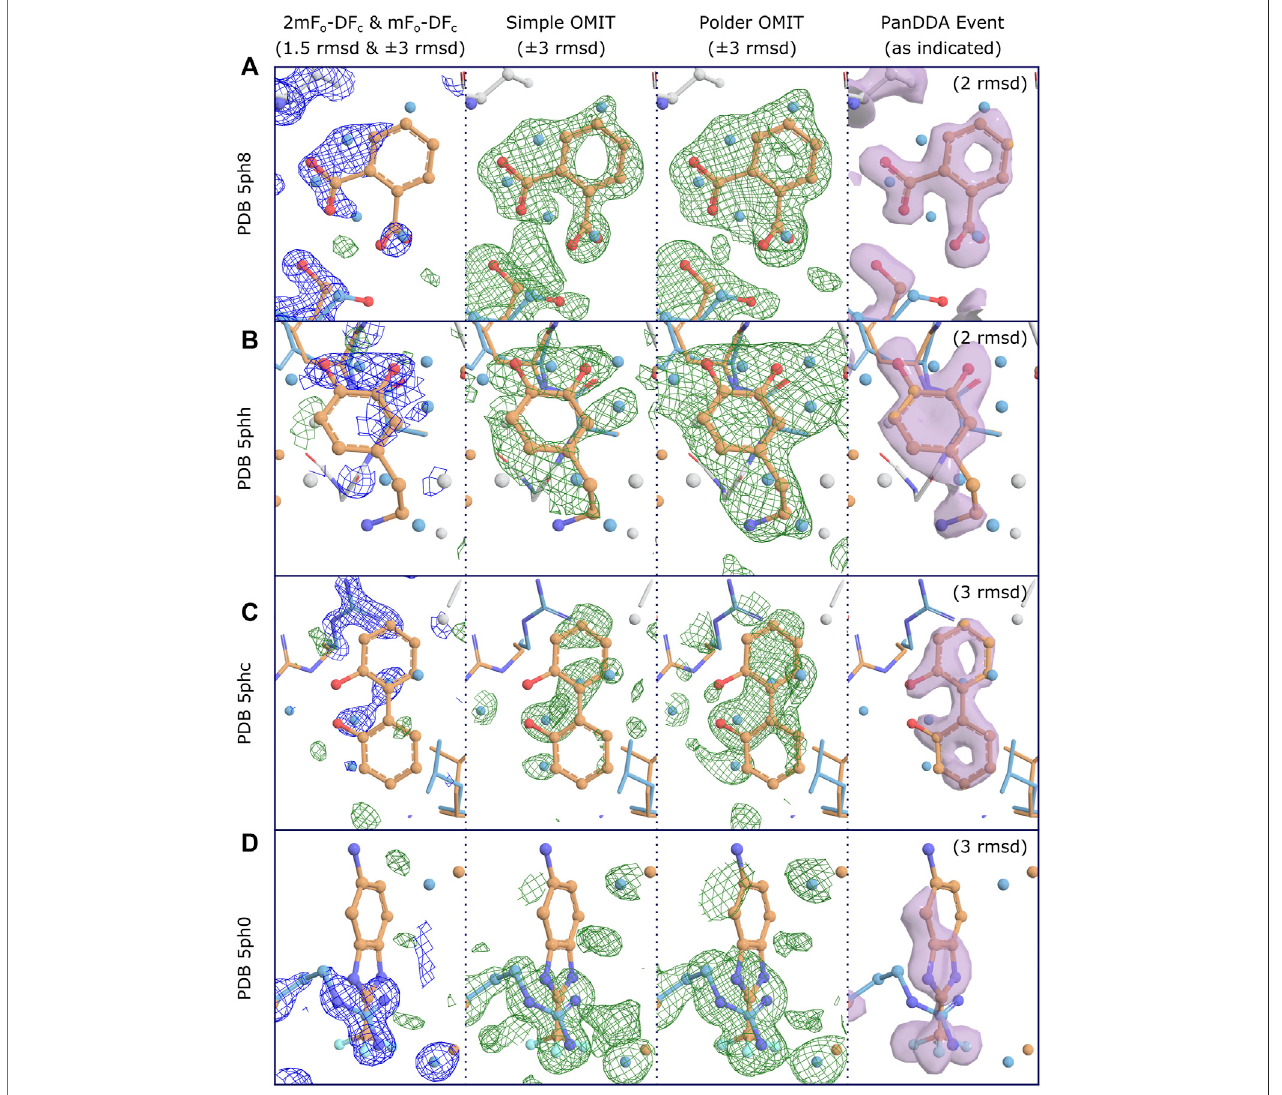
FIGURE 2 | Conventional OMIT maps do not generally produce clear unambiguous evidence of binding for low occupancy ligands, even at high resolution. Examples forfour binding fragments showing different levels ofsupport for binding from OMIT maps, where clear evidence of binding isshown by PanDDA event maps. Map coloring: 2mF o -DF c maps are shown as blue mesh and all difference maps are shown as green/red mesh; associated PanDDA event maps are shown as purple surfaces. Map type and contour are as indicated. Both types of OMIT maps are produced by phenix.polder. Maps are truncated (carved) at 3Å around relevant residues and ligands for clarity; PanDDA maps are carved at 2Å. Model coloring: To distinguish alternate conformations, carbon atoms for ligand-associated conformations are coloured orange and non-ligand-associated conformations are coloured blue; main-conformation (full-occupancy) atoms are coloured light gray; all other atoms are colored by element except waters, which are coloured as per carbon atoms. Resolutions: (A) 1.40Å, (B) 1.60Å, (C) 1.29Å, (D) 1.34Å. Re fi ned ligand occupancies: (A) 0.41, (B) 0.50, (C) 0.38, (D) 0.22.PanDDAeventmappseudo-occupancies(1-BDC): (A) 0.15, (B) 0.17, (C) 0.10, (D) 0.11. (A) Bindingisnotevidentin the 2mF o -DF c maps at a moderate contour level, but is clearly supported by both types of OMIT map, especially when considered in combination with the extra density from the superposed water molecules from non-ligand-associated conformations, as modeled. It is debatable whether the OMIT maps alone would provide strong enough evidence to support modeling of the ligand, but the single ligand conformation is clearly evidenced in the PanDDA event map, preventing potential misinterpretation of the OMIT map as multiple conformations of the ligand. (B) Similar to (A) , but with less evidence in the simple OMIT map. The polder OMIT map provides an envelope which fi ts well with the envelope provided by the ligand and the superposed water molecules, as modeled. It is unlikely either OMIT map would be acceptedasevidenceofbinding,butoncemore,theligandconformationisclearlyidenti fi edintheeventmap. (C) OMITmapsshowmostlyfeatureswhichcorrespondto superposed (not-ligand-associated) waters, and do not present evidence for the bound ligand, unlike the event map. (D) Ligand binding coincides with an alternate conformation of an arginine residue, which dominates the re fi ned maps and OMIT maps.